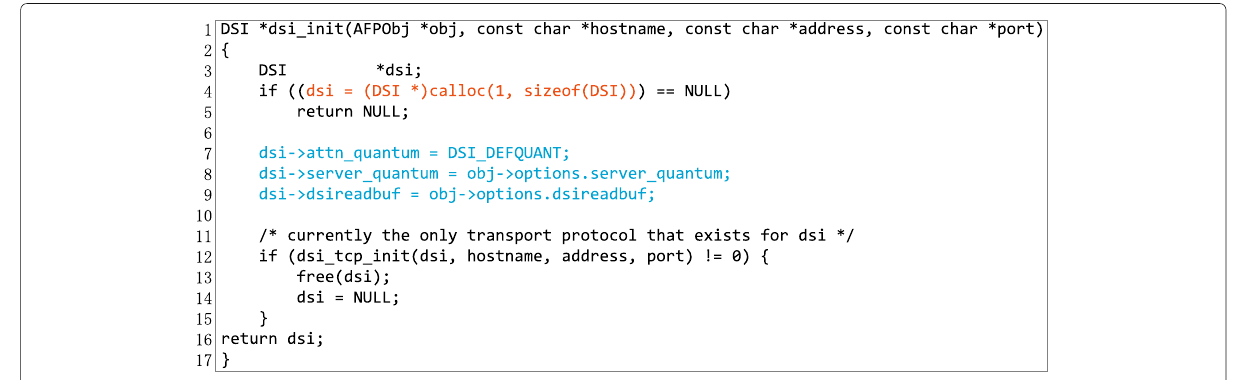
Fig. 15 The initialization code in Netatalk